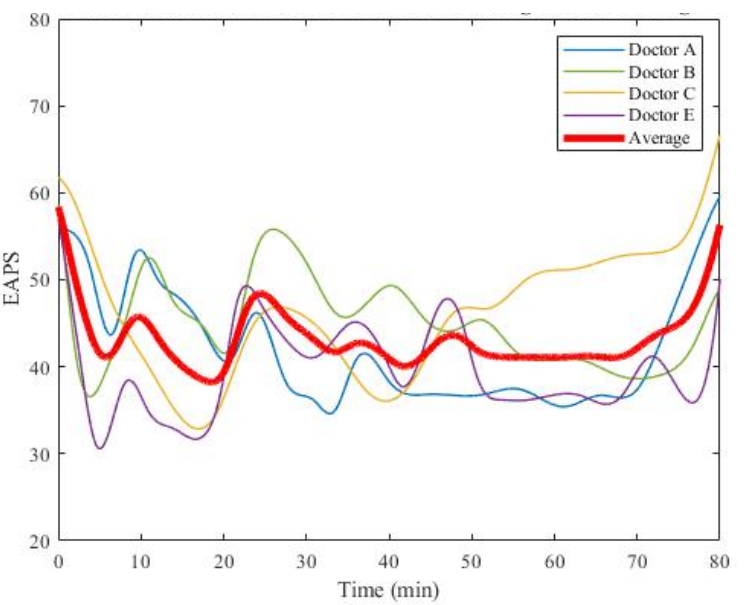
Figure 16. An average of the EAPS values from the four physicians.